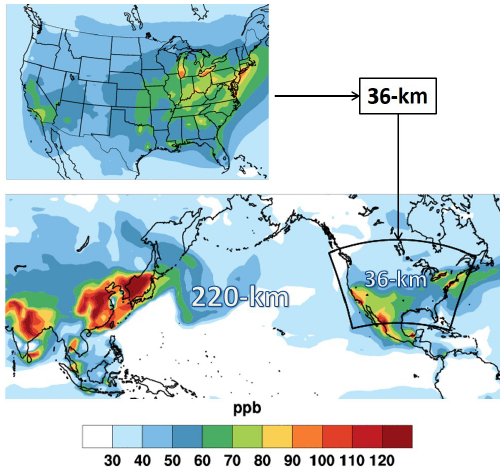
Figure 1. Projected future DM8O concentrations with future an- thropogenic and biogenic emissions for the 220 and 36km CMAQ modeling